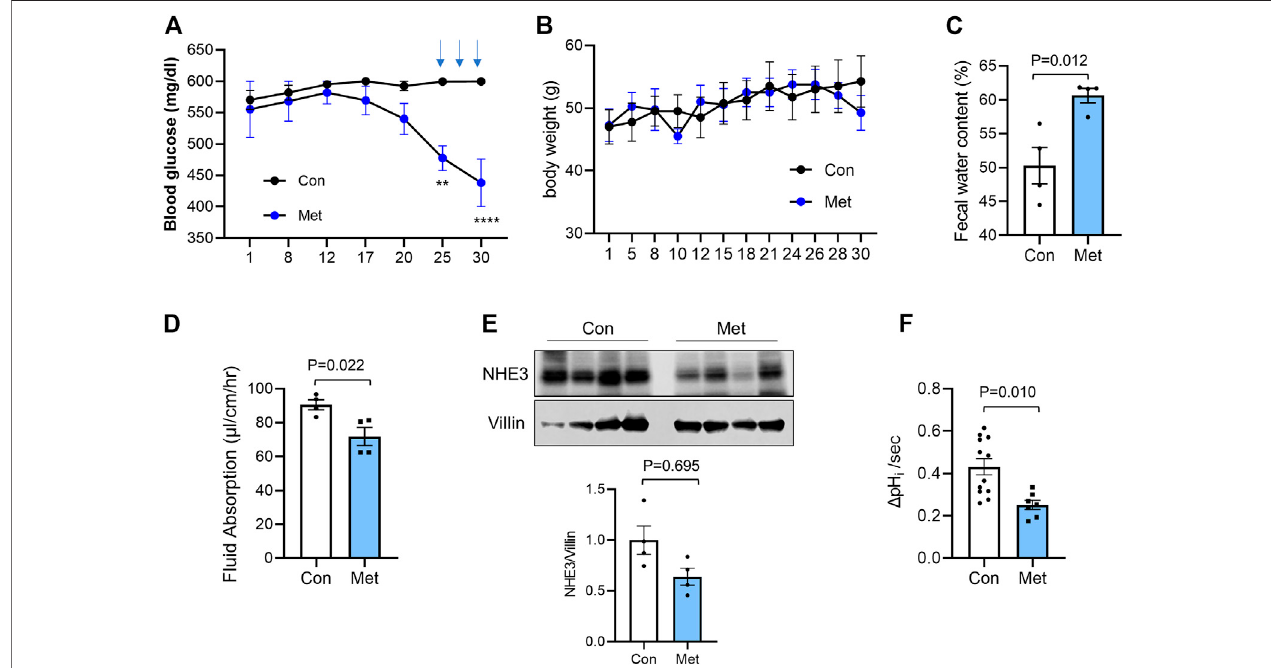
FIGURE1| Metformin decreases intestinal waterabsorptionin db/db mice Metformin wasadministered to db/db mice indrinking water(1 mg/ml) for30 days.On day 25, 27, and 29, metformin (500 mg/kg) was administered once a day by gavage. Blood glucose (A) and body weights (B) were determined. Data are presented